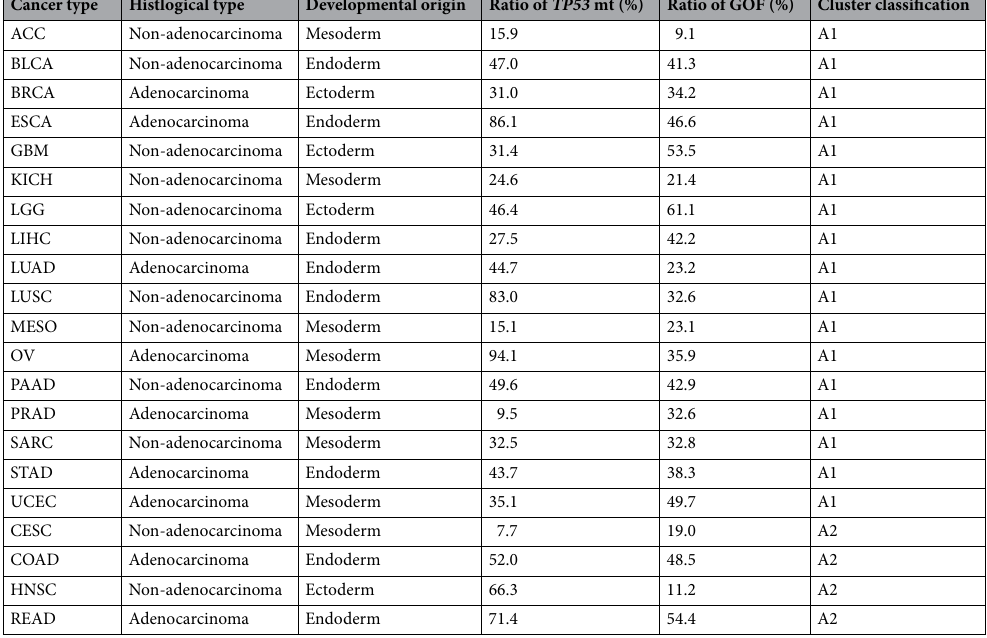
Table 1. Histological type, developmental origin, TP53 mutation rate, GOF mutation rate, and cluster classification for each cancer type in cohort